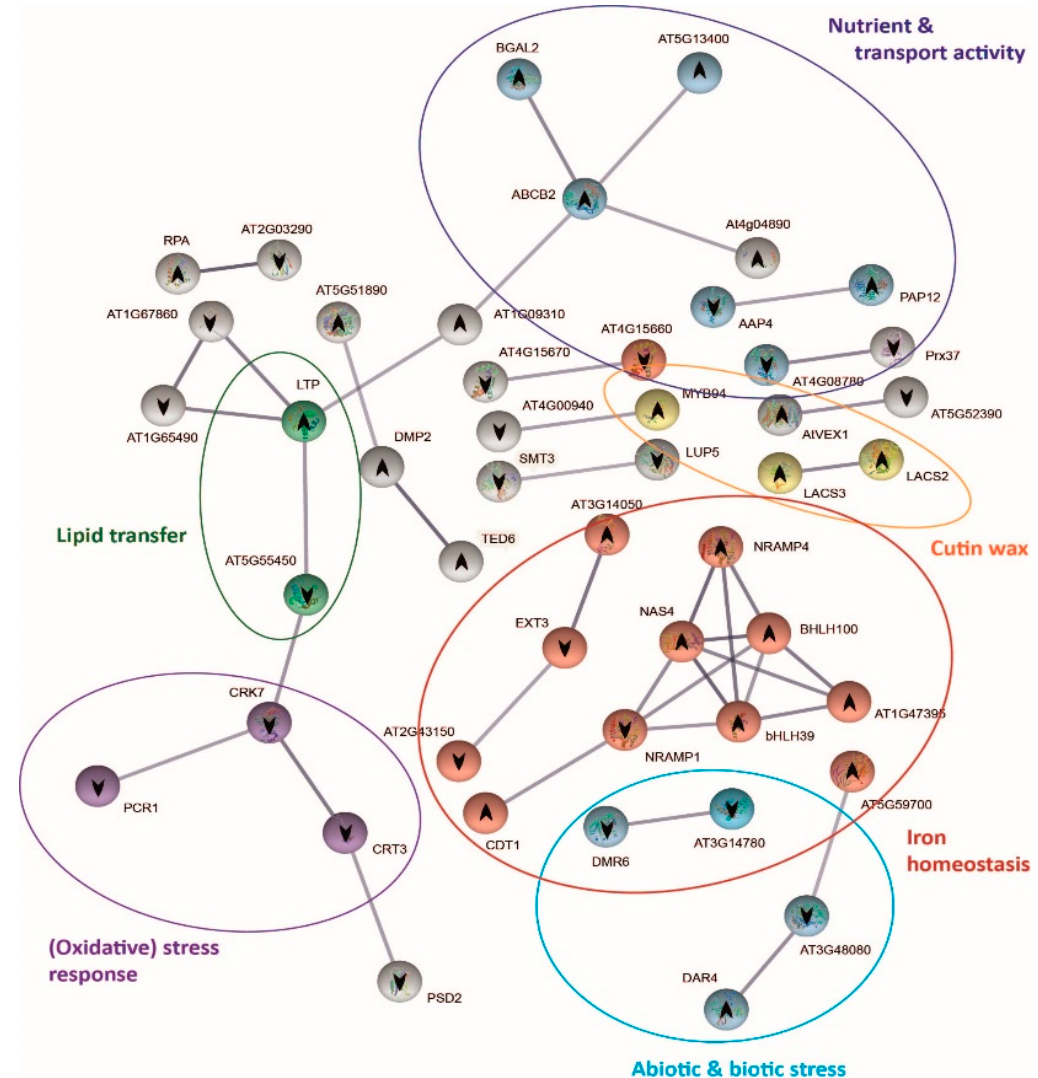
Figure 6. Protein–protein interaction network functional enrichment analysis of specific genes derived from the response to bicarbonate of T6 (c − ) . Gene protein interaction network of T6 (c − ) exclusive DEGs from bic vs. pH 5.9 comparison after 3 h exposure. Each sphere corresponds to one gene and nodes represent protein interactions. Gene pathways are shown in different colors. Arrows indicate up or downregulation of the genes.